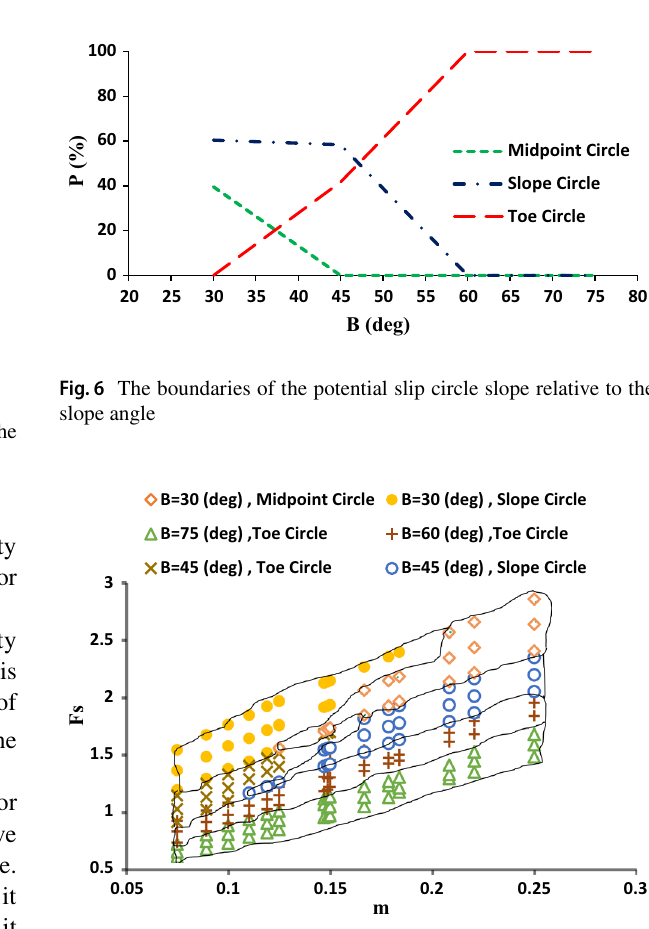
failure circles (toe, slope or midpoint circle) may occur. For angles larger than 45 and less than 60 (45° < β < 60°), two modes of failure may occur: midpoint circle and toe circle.